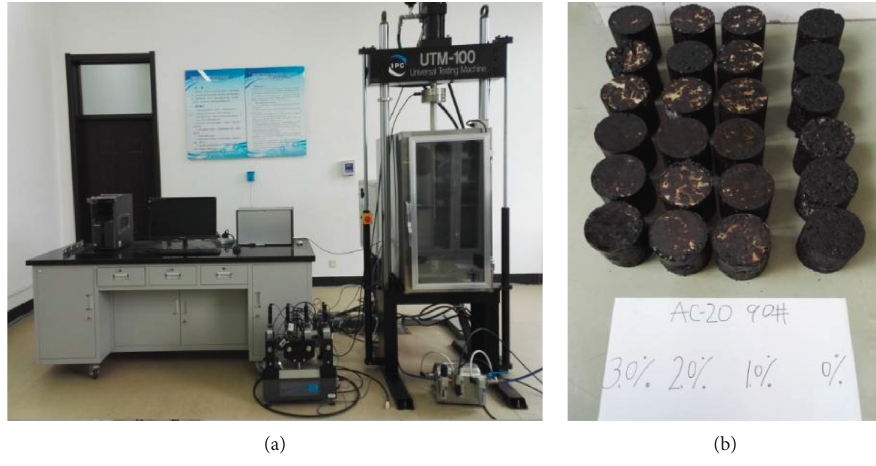
Figure 3: UTM-100 equipment and foam asphalt mixture preparation test piece.